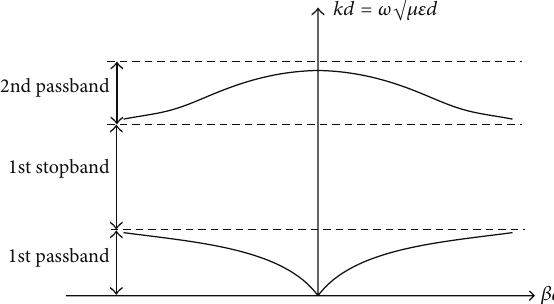
Figure 8: 𝑘 - 𝛽 graph of passband and